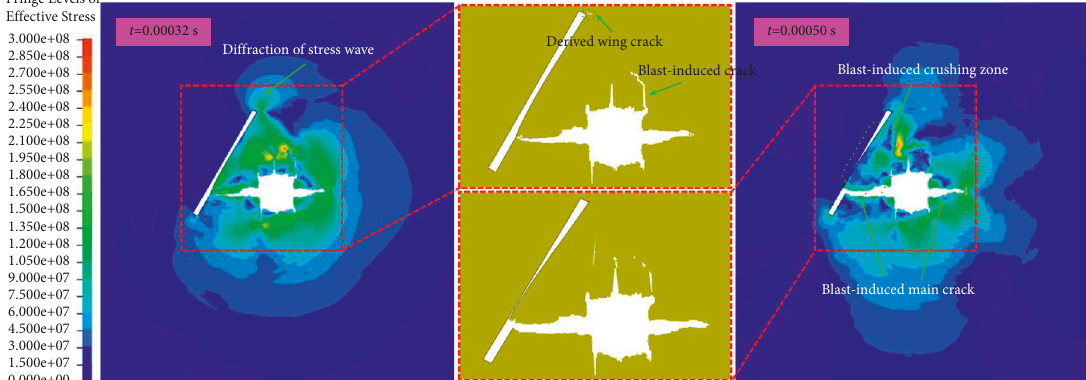
Figure 8: Pressure diagram of explosion stress wave transmission for case CN